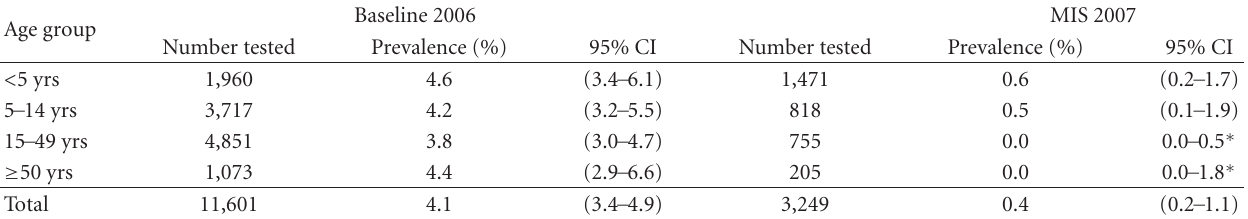
Table 4: Prevalence of malaria by blood slide microscopy by age group in malarious areas of three regional states.